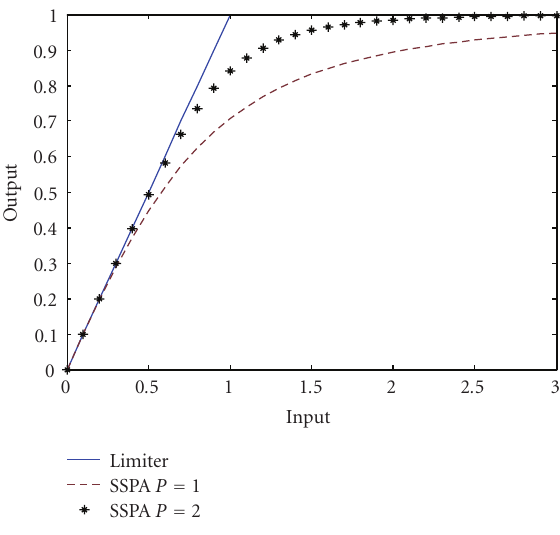
Figure 3: AM/AM conversion of HPA.